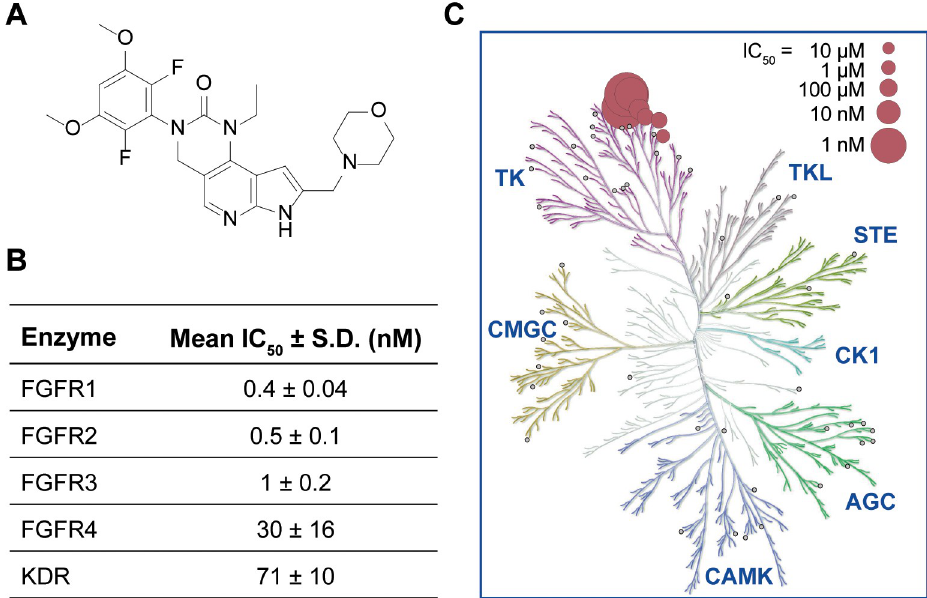
Fig 1. Molecular structure and In Vitro profile of INCB054828. (A) Molecular structure of INCB054828. (B) Potency of INCB054828 against FGFR kinases. Activity of recombinant human enzymes was assayed as described at the Michaelis–Menten constant (Km) ATP for each enzyme. The mean IC 50 and S.D. for 6 (FGFR4) or 8 (FGFR1, FGFR2, FGFR3, KDR) independent experiments using multiple lots of inhibitor is reported. (C) Selectivity profile of INCB054828. Biochemical IC 50 values of INCB054828 for 56 kinases. Small gray circles indicate tested kinases with IC 50 > 10,000 nM. Among non-FGFRs, KDR and c-KIT were the only kinases inhibited with an IC 50 value < 1,000 nM.